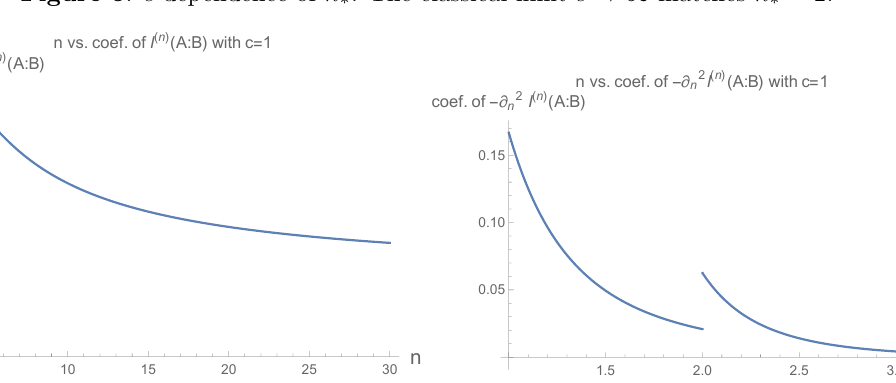
Figure 5 . c dependence of n (cid:3) . The classical limit c ! 1 matches n (cid:3) = 2.